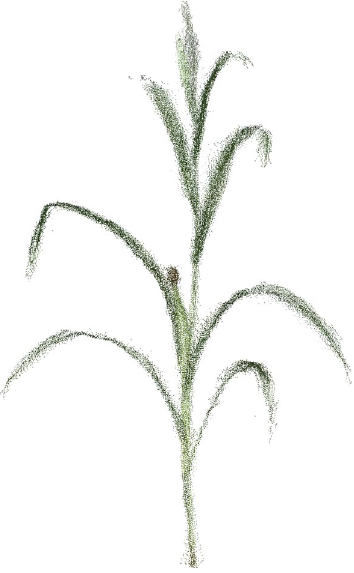
Figure 12. Effect diagrams of precise registration.